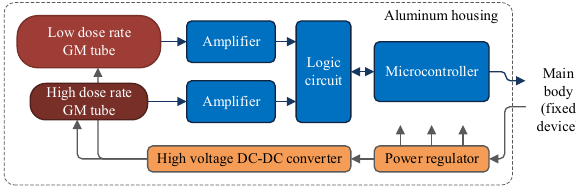
Figure 2. Structure of the primary detector module with the GM